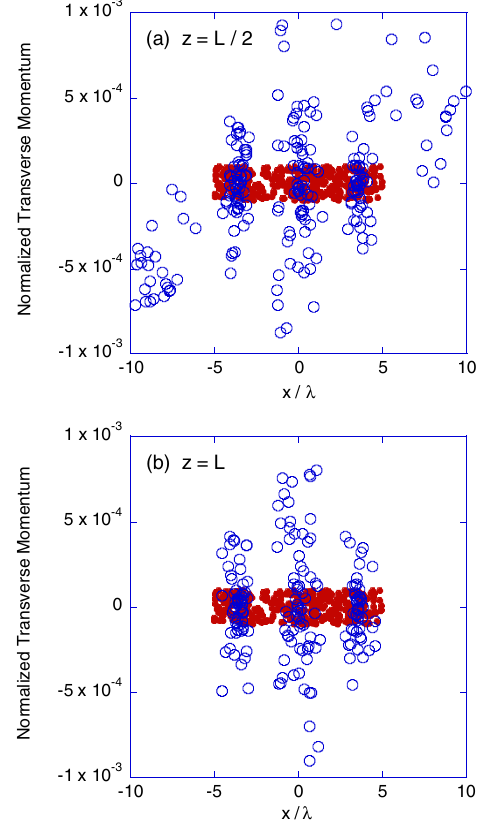
FIG. 2. Phase space in the space-charge-free case. The trapping of particles in the vicinity of the equilibrium points is evident: j ¯ x eq j ∼ 0 and j ¯ x eq j ∼ 3 . 512 . The initial beam ’ s phase space does ∼ 6 . 43 Þ since j ¯ x j < 5 ; not cover the third equilibrium ðj ¯ x eq j therefore, electrons are not trapped in this state. (a) At z ¼ L= 2 . (b) At z ¼ L